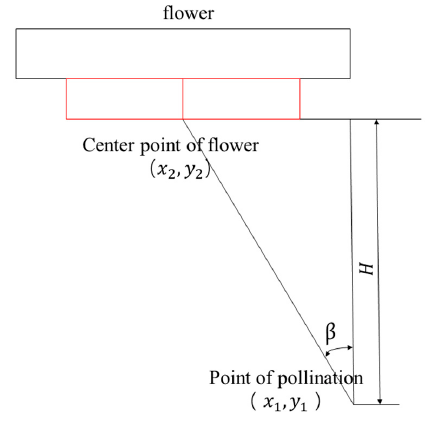
Figure 7. Pollination of the centre point of the fl ower.